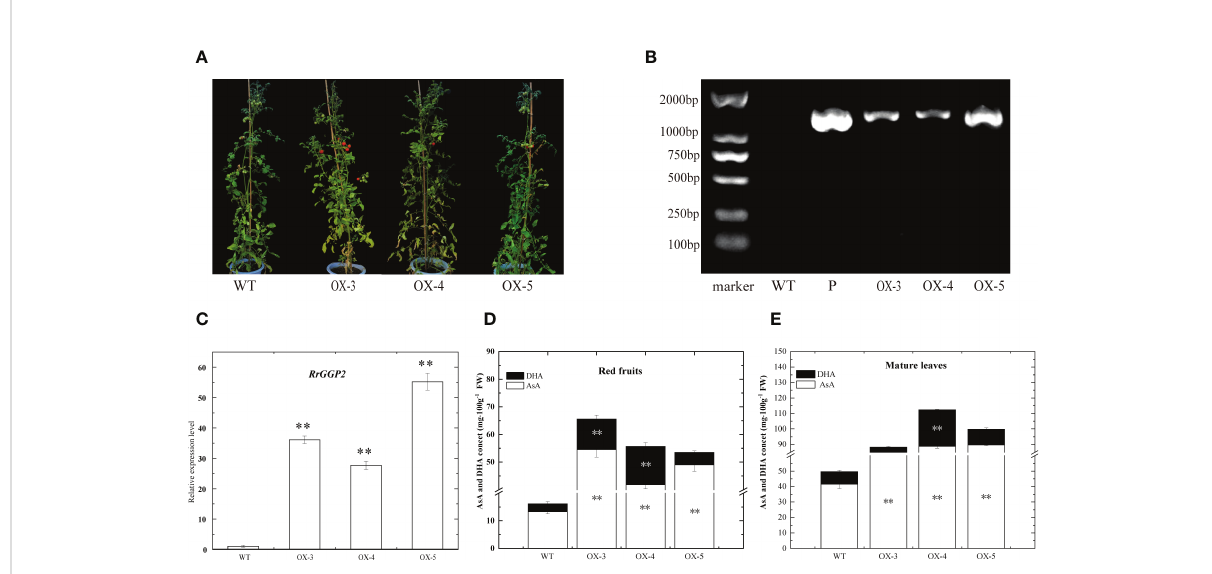
FIGURE 7 AsA content in tomato overexpressing RrGGP2 . Transgenic lines (A) and con fi rmation of the presence of transgenes in the RrGGP2 - overexpressing tomato lines by a PCR ampli fi cation (B) and qRT – PCR (C) . P, positive control, WT, untransformed control plants, OX-3 – OX-5, Transgenic tomato plants, ** Represents p<0.01. AsA and DHA content in red fruit (D) and mature leaves (E) of RrGGP2 transgenic tomato lines. **Represents P < 0.01 compared with WT, white represents DHA, and black represents